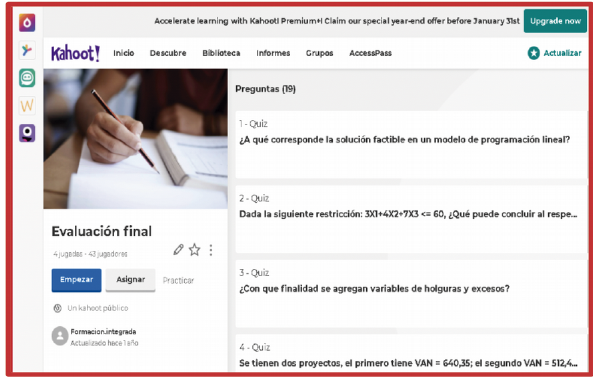
Figure 5. Linear Programming Kahoot with Solver and Project Evaluation